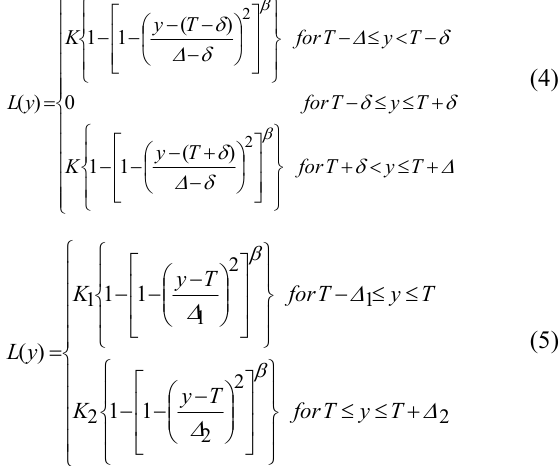
, K in PLF have the same 1 2